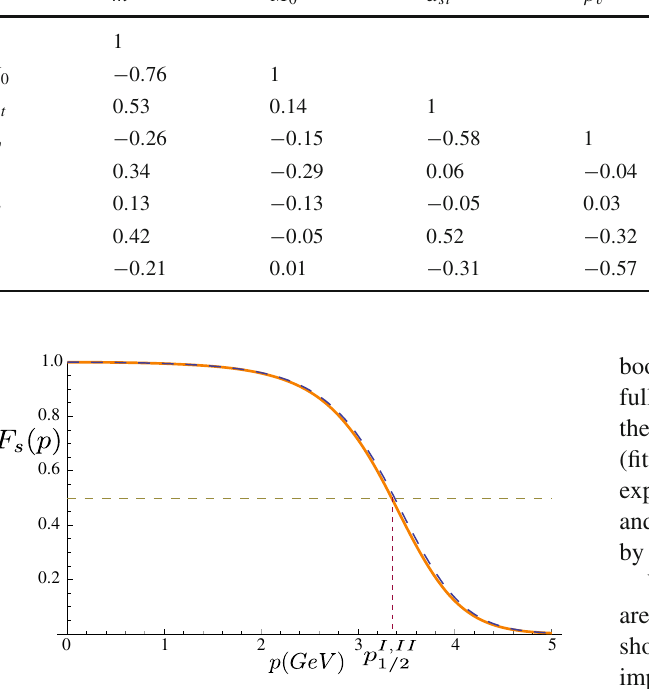
(potential I) and p II 1 / 2 1 / 2